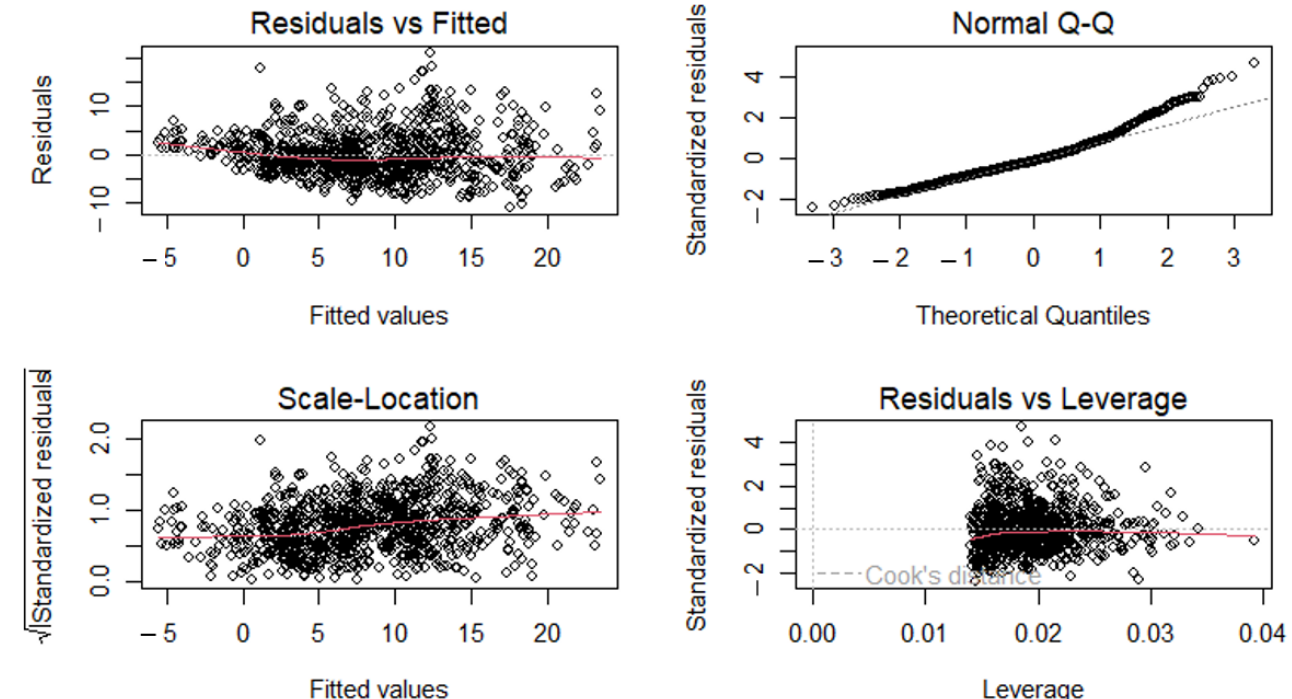
Figure 8. MLR model residual statistics. Clockwise from upper left: (1) Comparison of the residuals of the MLR model against the fitted values produced by the model, the red lines indicate a LOWESS fit; (2) quantile–quantile plot: confirms that both sets of quantiles came from the same (normal) distribution, except the upper quantiles, where the points stray above the line, indicating some deviation of the error from normality; this, however, is a small portion of the data; (3) scale– location plot: uses the square root of the standardized residuals instead of the residuals themselves; (4) leverage plot: no standardized residuals are outside of the Cook’s distance boundaries, indicating that there were no strong outliers influencing the regression results.